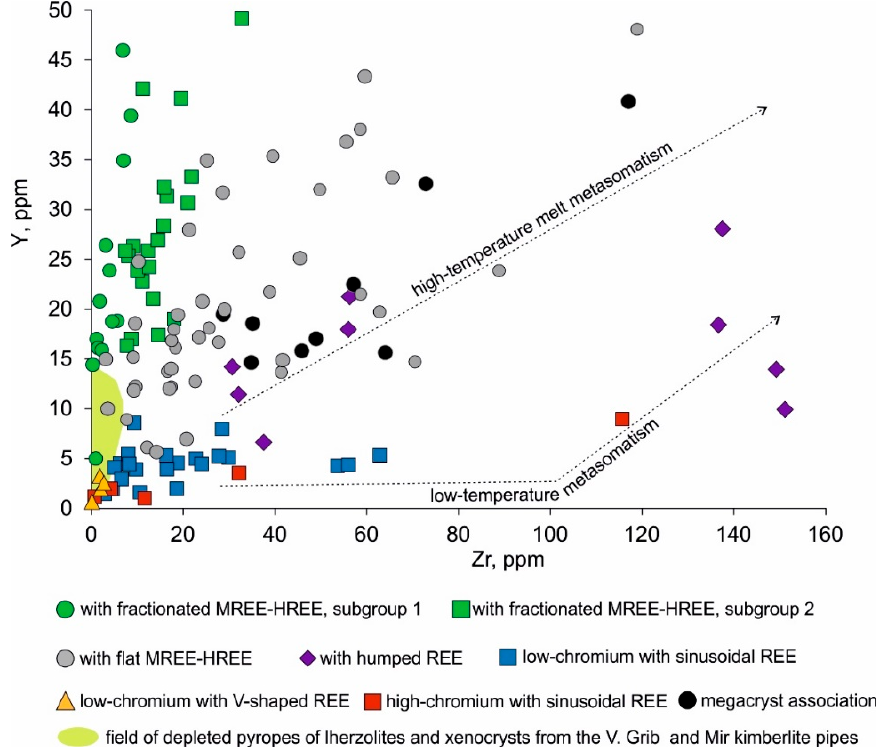
Figure 4. Y vs. Zr in pyropes from the southern Arkhangelsk region. Pyropes from the V. Grib pipe lherzolites and xenocrysts [14,15] and xenocrysts of the Mir pipe [18]. Trends of high- and low-temperature metasomatism [21].